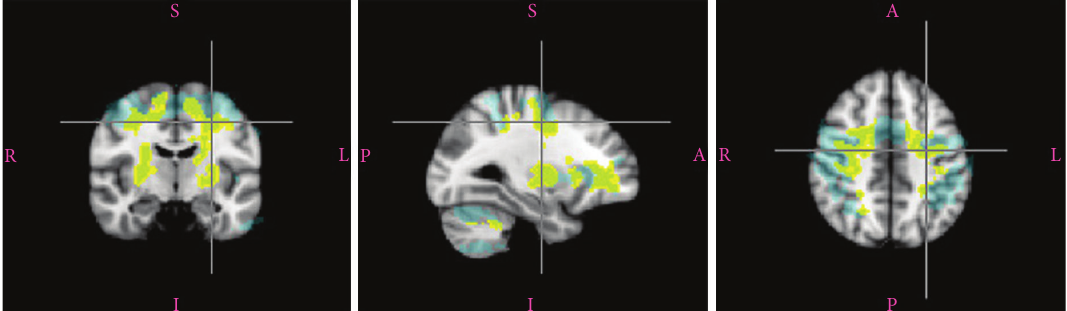
Figure 3: Creation of the white matter mask from the fMRI-activated areas: the yellow regions are regions activated during the contrast analysis of the young population (young only). The activated areas are then enlarged to the adjacent brain by a radius of 5 mm (blue regions). Then a mask is applied to keep the white matter only (not represented on the